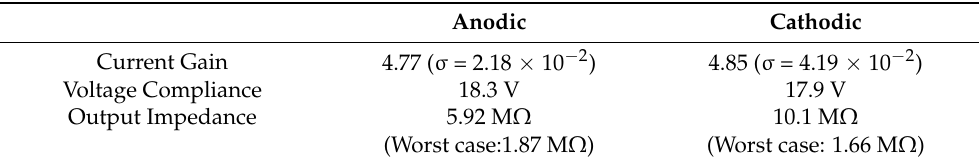
Table 1. ECS static characteristic (Average values, σ for the standard deviation when given. Statistics on 24 measured channels. Worst case is the minimal measured value for current sources output impedances).